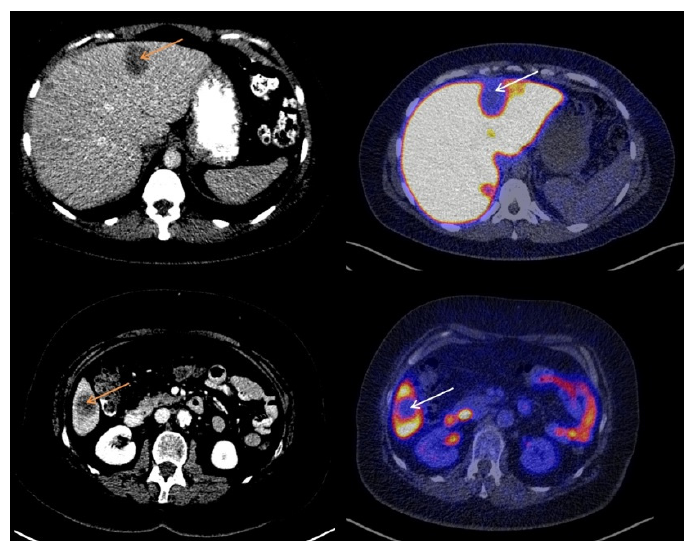
Figure 1. Two cases of low [ 18 F]-FES uptake at the site of an ER − liver metastasis.